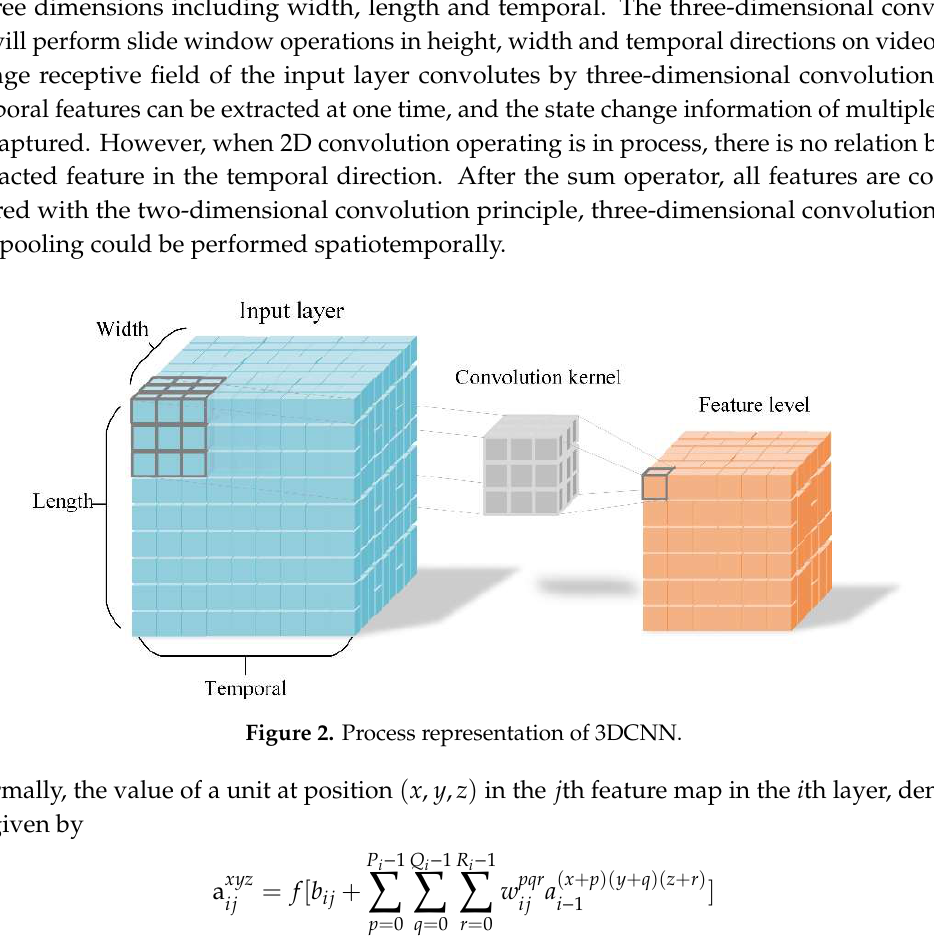
represents the activation function.